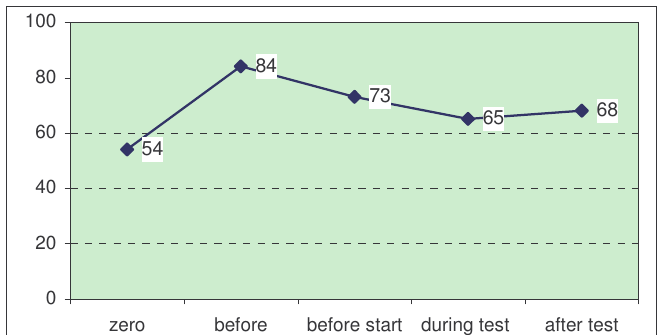
Figure 3. Development of ISA acceptance in % of test drivers